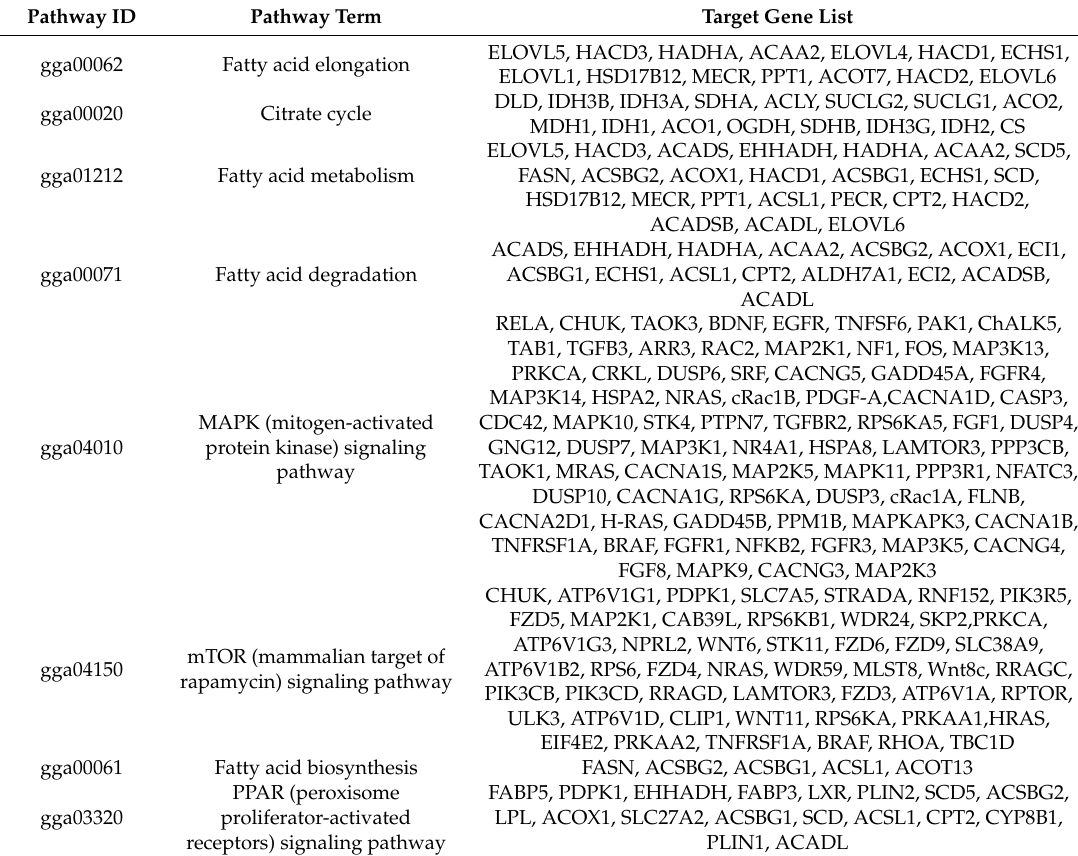
Table 2. The eight significantly-enriched pathways related to lipid